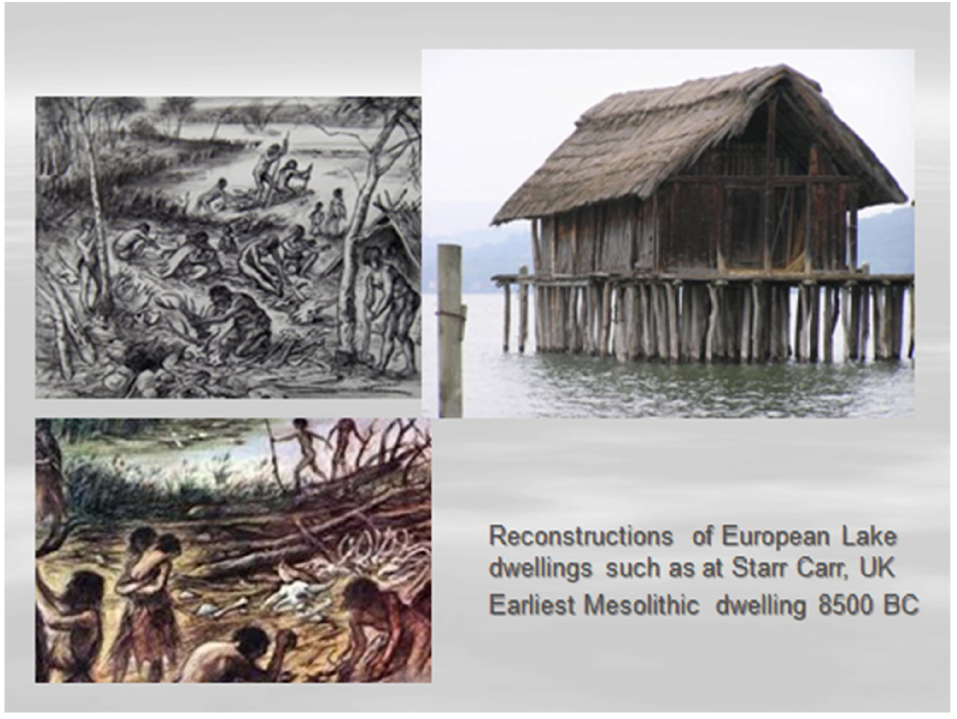
Figure 5. Early prehistoric communities were completely reliant on lake and river marginal wetlands throughout Europe for food, shelter, and security. Source: